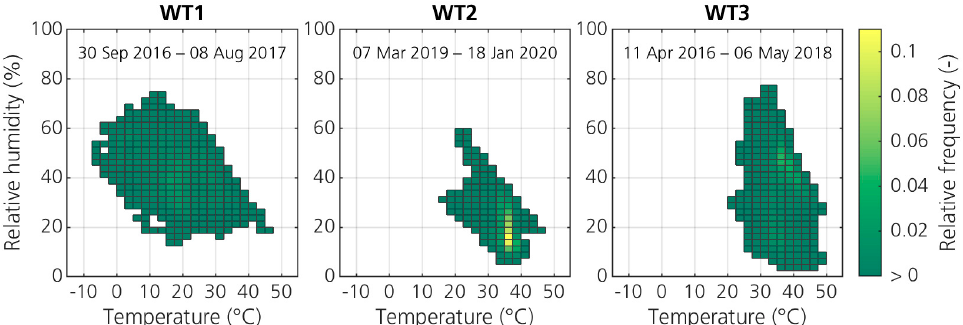
Figure 11. 2D frequency distributions of temperature and relative humidity inside the converter cabinets of the three wind turbines WT1–WT3 based on data from the complete measurement periods indicated in the plots (WT1: onshore in Germany with air-cooled converter in the tower base; WT2: in the German North Sea with liquid-cooled converter in the nacelle; WT3: onshore in India with liquid-cooled converter in the tower base).